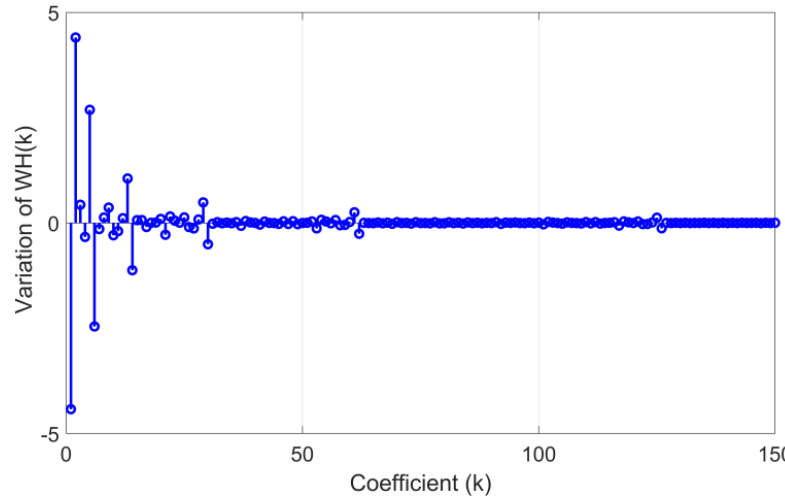
Figure 4. Change in Walsh transform coefficients in a fault condition in transistor T 1 U .